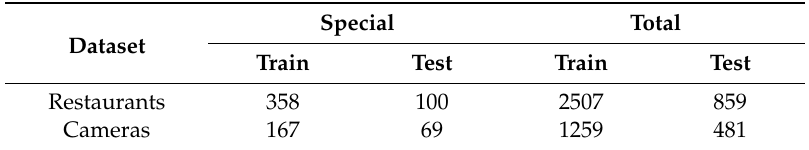
Table 4. The Summary statistics of inverted sentences on Restaurants and Cameras datasets. Special stands for the number of sentences where the target is in front of its description and the distance between them is more than two